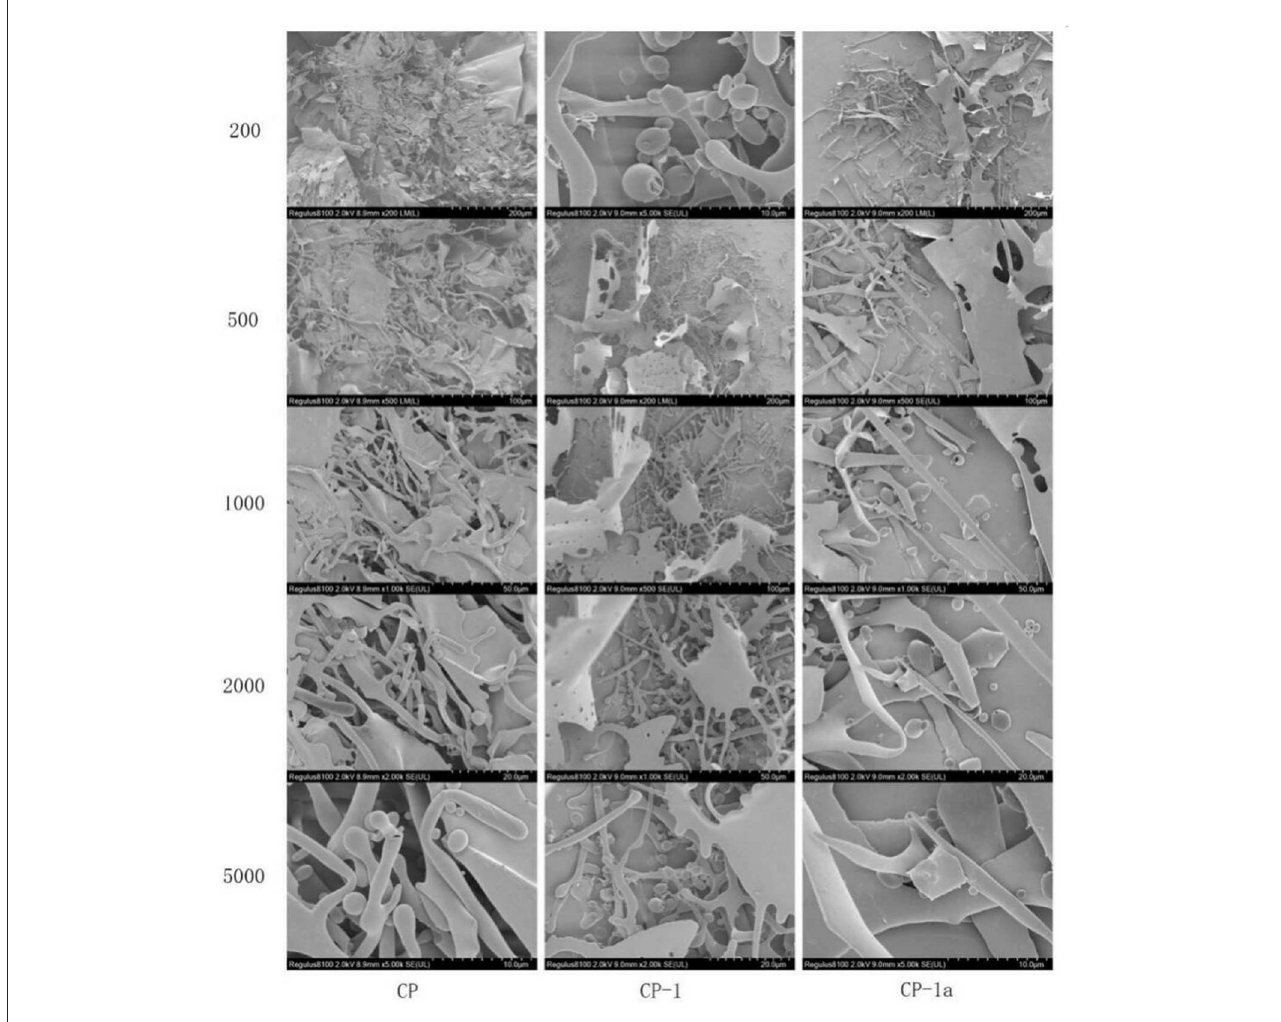
FIGURE9 Scanning electron microscopy of CP, CP-1, and CP-1a.